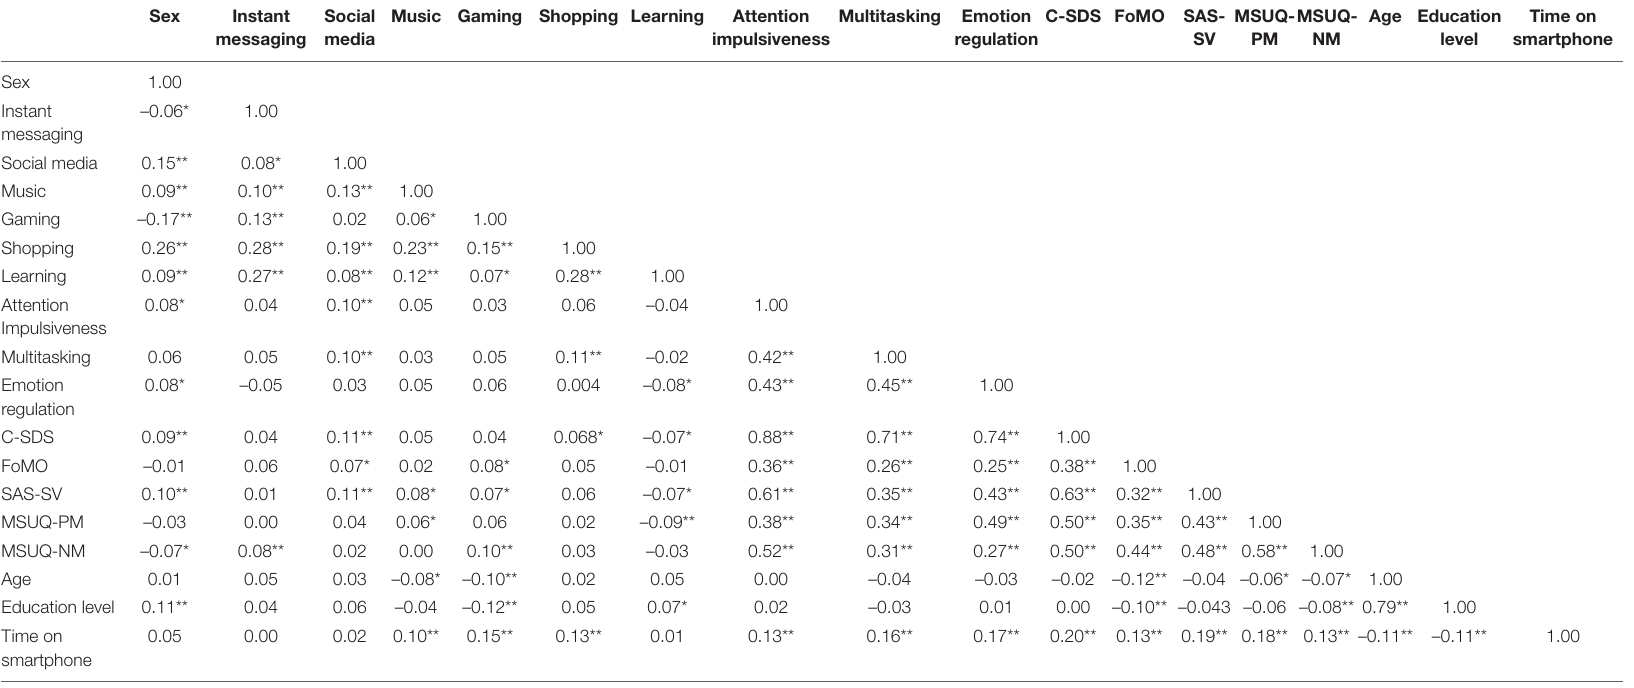
TABLE 4 | The correlations between C-SDS and other